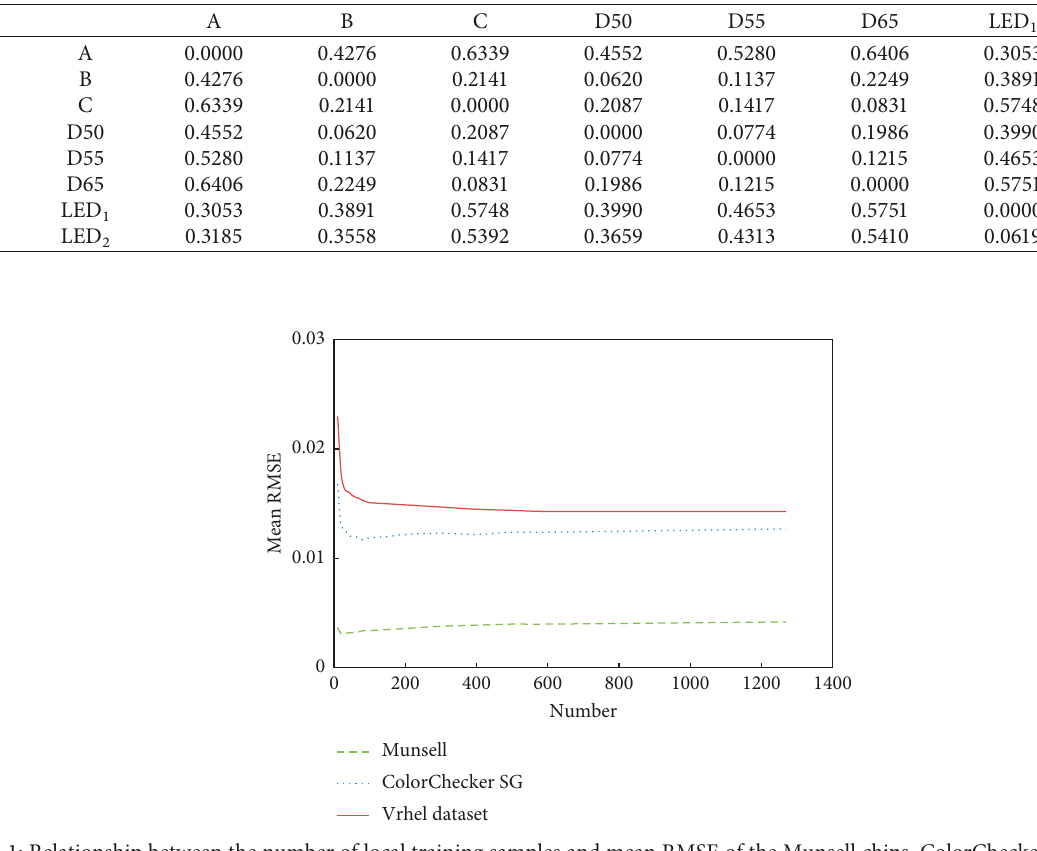
Table 2: Spectral angle mapper (SAM) statistics for two reference illuminants.